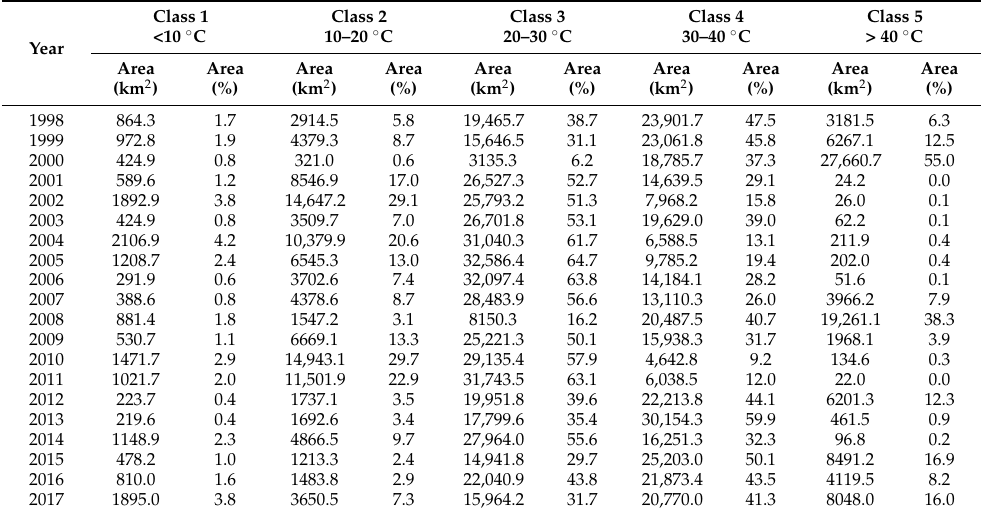
Table 4. LST Categories Derived from Landsat Thermal Bands for the Years 1998–2000 and Drought Severity Areas (in km 2 ) and Percentage based on the LST